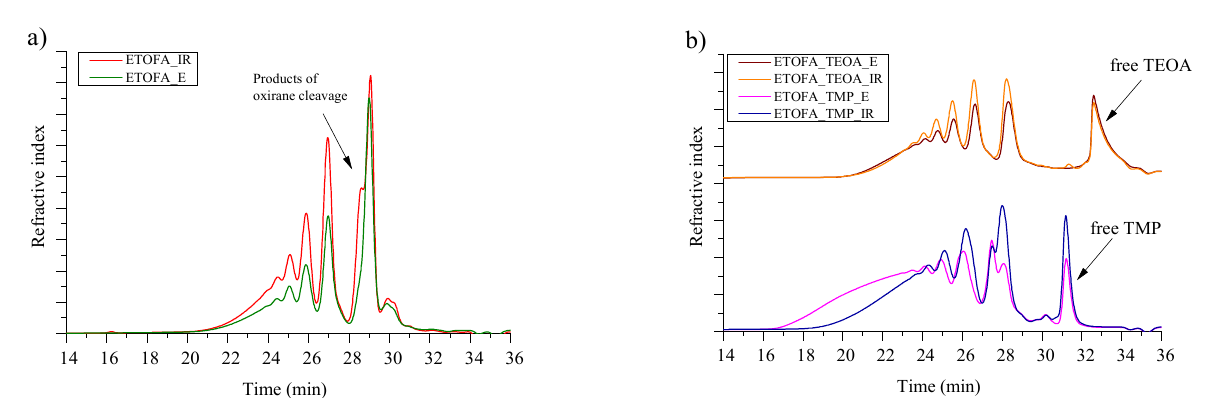
Figure 5. SEC chromatograms of ( a ) different ETOFA and ( b ) developed TOFA bio-polyols.